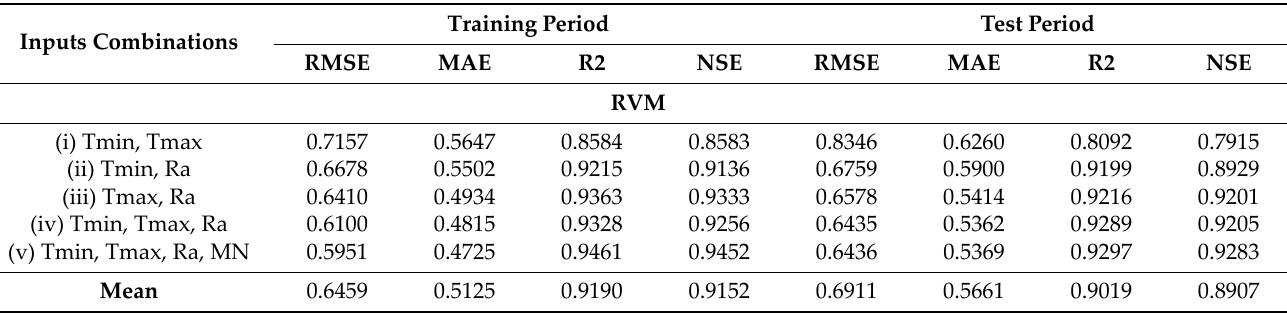
Table 6. The results of the RVM‑based models for Peshawar Station using the best training‑test par‑ tition (75–25%